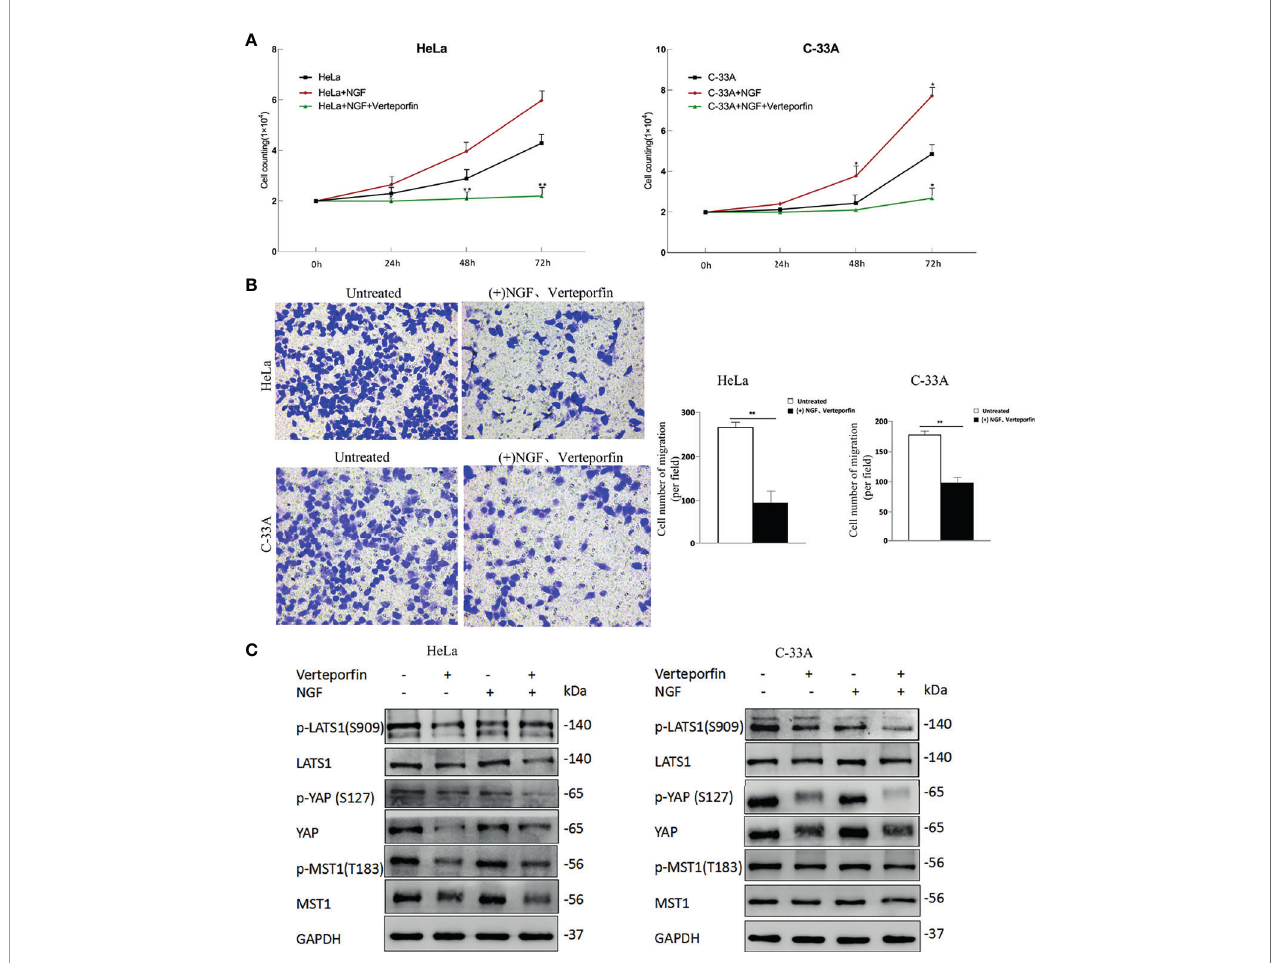
FIGURE 4 | Vertepor fi n eliminates the effect of NGF through the Hippo pathway in vitro . (A) The numbers of HeLa and C-33A cells were treated with 200 ng/ml b -NGF and Vertepor fi n (1 m M); the numbers of cells every 24 h for 72 h were counted. (B) Representative photographs showing transwell assays in the presence of NGF in serum-free medium for 24 h with Vertepor fi n (1 m M) (left panel). Quanti fi cation of cell number ofmigration (per fi eld) estimated from three independent experiments (right panel). Magni fi cation:200 ×. (C) The samples were HeLa orC-33A celllysates maintained in serum-free medium for 24 h with or without 200 ng/ml b -NGF treatment and Vertepor fi n (1 m M). GAPDH was used as a loading control. Data are shown as the mean ± SD inthree independentexperiments. *P < 0.05, **P <